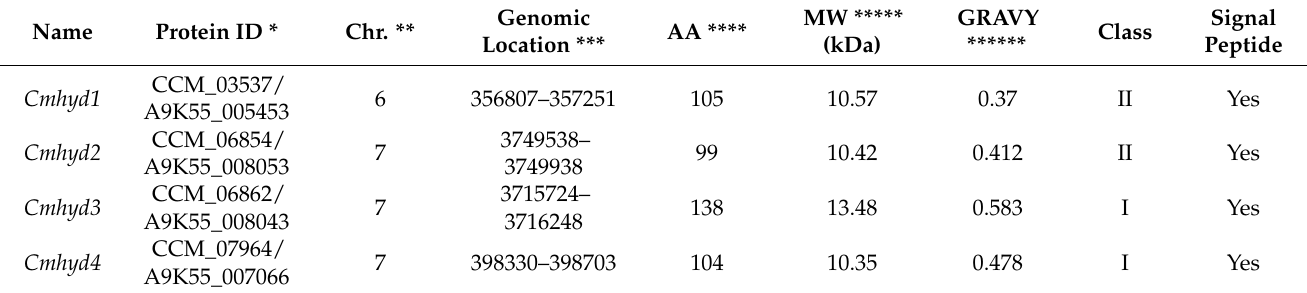
Table 1. Hydrophobins identified in the genome of Cordyceps